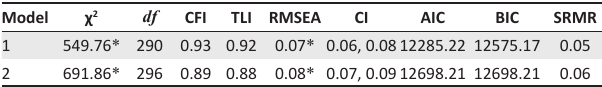
TABLE 1: Measurement models ( n = 207).